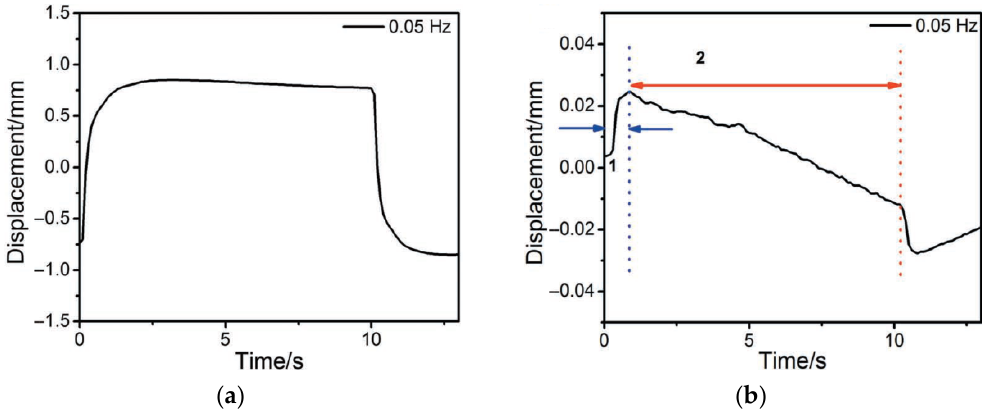
Figure 8. Actuation curves for meander-type signals of the actuator with electrodes from ( a ) RGO/Ag and ( b ) Ag. The frequency and the amplitude of stimulation are 0.05 Hz and 1 V, respectively. Reproduced from [31] with permission from John Wiley and Sons. Copyright 2012.